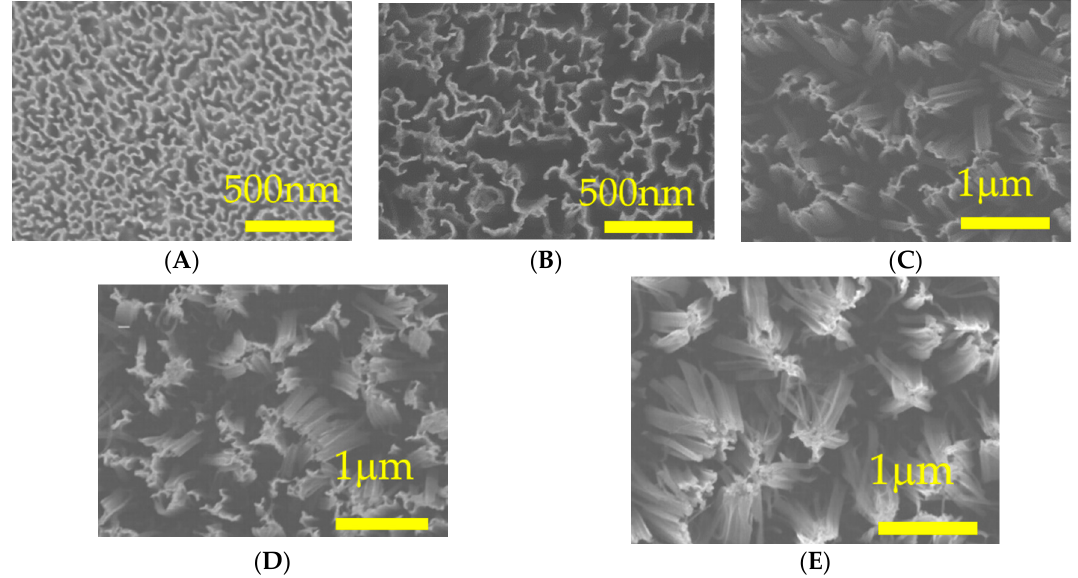
Figure 3. Top-view SEM images of etched samples fabricated using electroless plating with AgNO 3 concentrations of ( A ) 0.0025 M, ( B ) 0.005 M, ( C ) 0.01 M, ( D ) 0.01 M, and ( E ) 0.02 M.